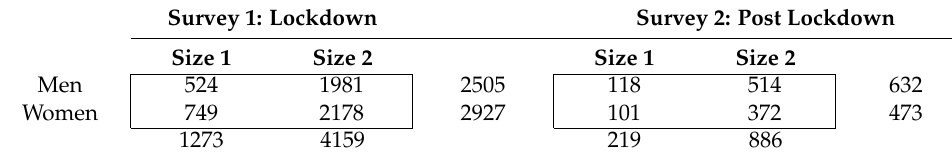
Table 5. Distribution of the sample sizes in each of the groups analyzed.